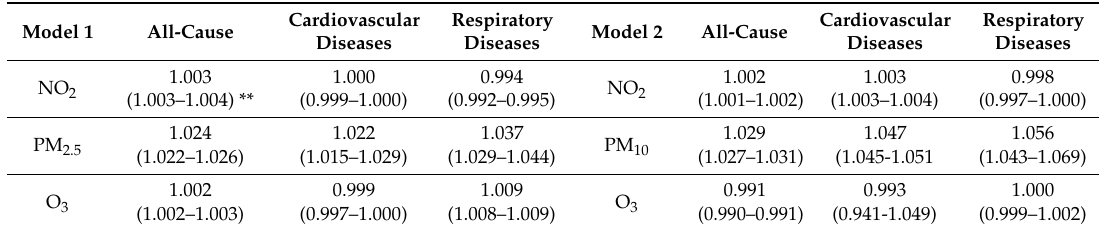
Table 1. Long-term risk for mortality in 2012 associated with air pollution * exposure in 1999–2000 at the departmental level in Metropolitan France in the CepiDc data.